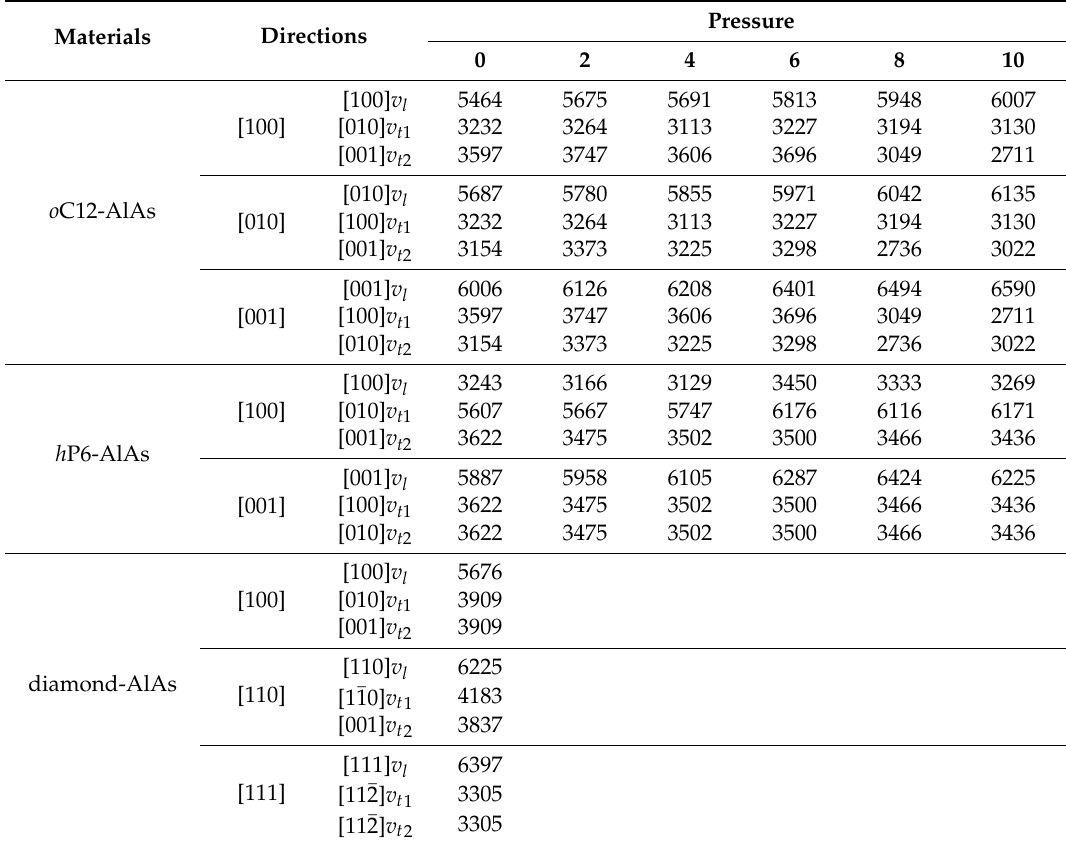
Table 3. The sound velocities along different directions of o C12-AlAs, h P6-AlAs, and diamond-AlAs under